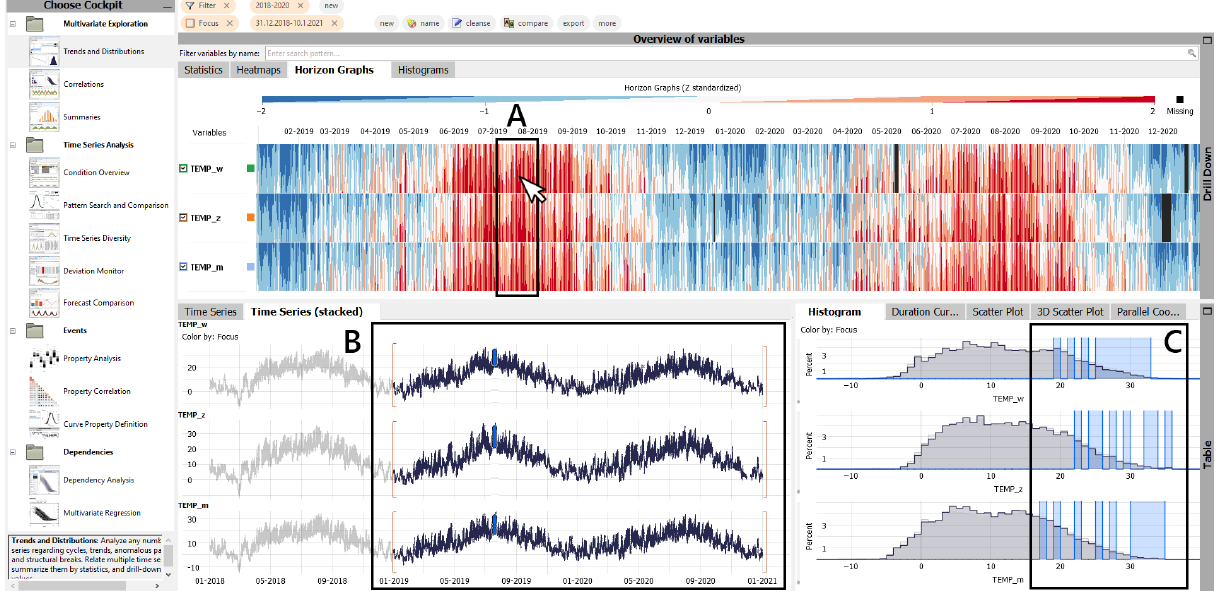
Figure 1. Illustration of real-time responsiveness to feature selection across 2D visual units within one computational cockpit: ( A ) by selecting a data sample from a horizon graph (top), ( B ) the corresponding data pair is highlighted in time series distribution (bottom left) and ( C ) histogram (bottom right) view across all active time series, allowing thus an instantaneous comparative analysis.